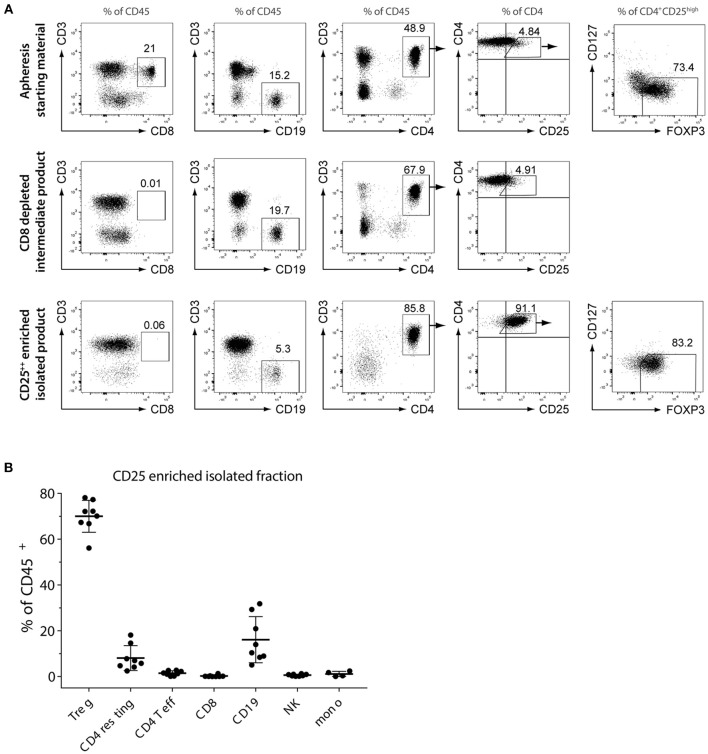
Quantification of CD4+CD25highCD127lowFOXP3+ Treg and other lymphocyte subsets before and after CD8−CD25high enrichment. (A) Phenotyping of initial cell source (leukapheresis), CD8+ depleted intermediate product and final CD25high Treg enriched fraction by flow cytometry. Shown are representative flow cytometry plots for one of the donors. (B) Relative percentage of Treg and contaminating CD4+CD25−/low (CD4 resting), effector memory CD4+CD25+CD127+CD45RO+ (CD4 Teff), CD8 cytotoxic T cells, B cells, NK cells and monocytes. Shown are individual and mean percentages (solid line) of CD45+ leukocytes of each subset for n = 8 Treg isolations. Error bars = SD.